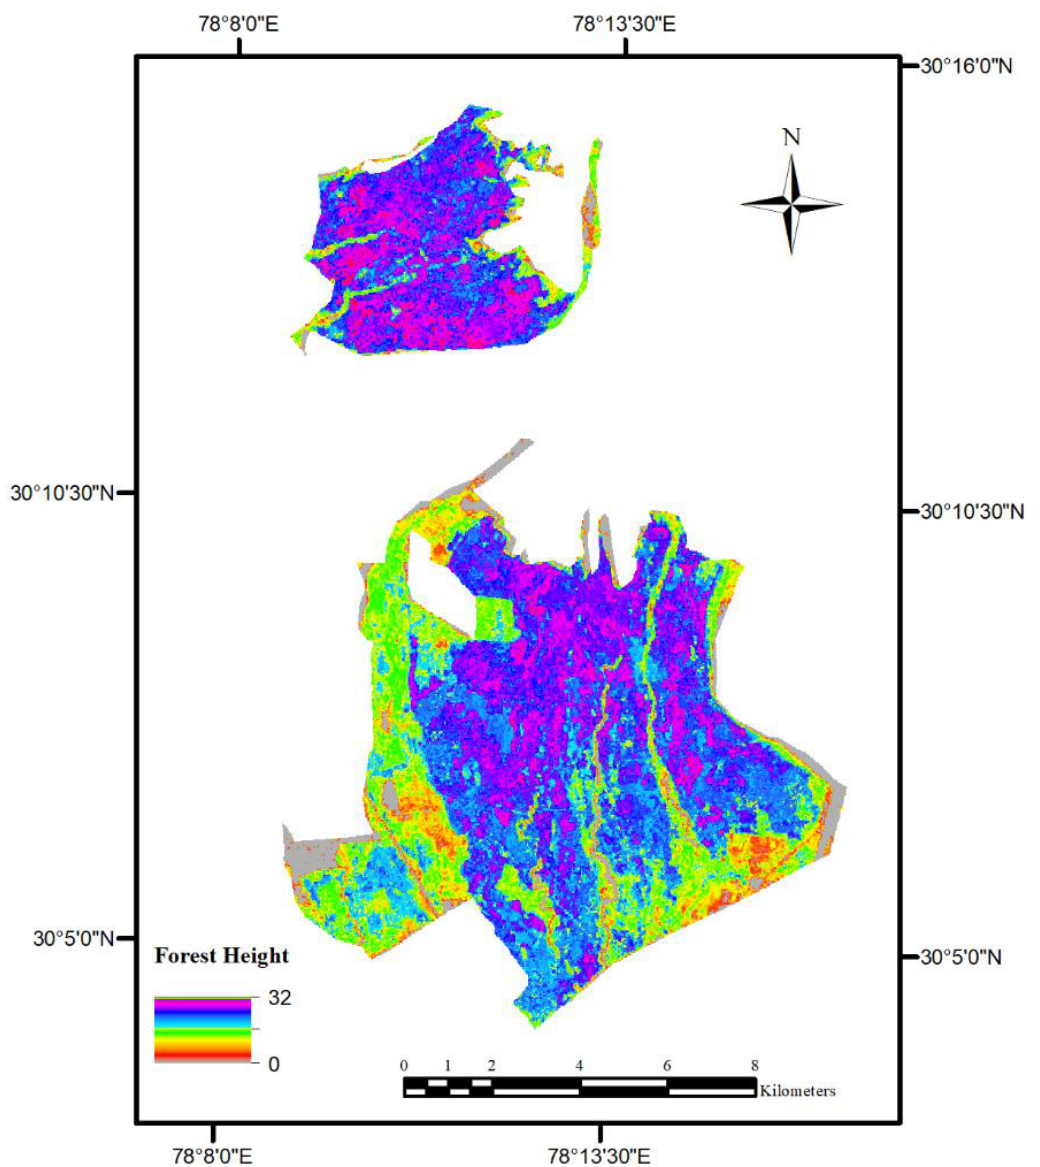
Figure 5. A subset of global forest canopy height map for the Barkot and Thano forest ranges.